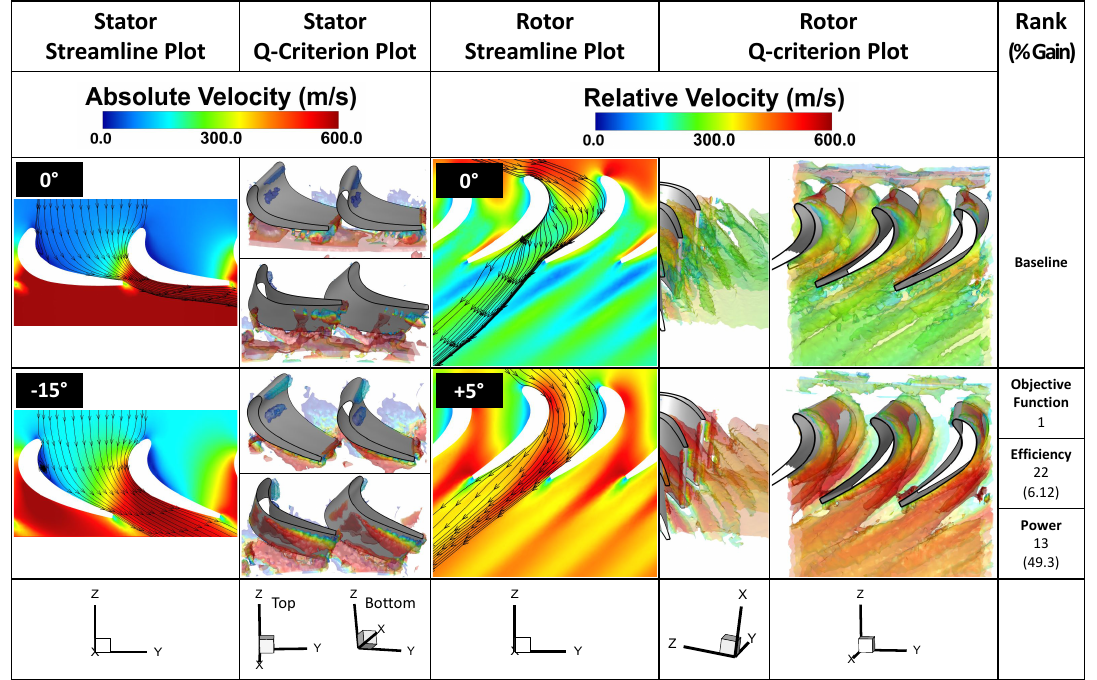
Figure 9. Flow field comparison using streamline and Q -criterion plots between the optimal and baseline cases. The stator plots use absolute velocity while the rotor plots use relative